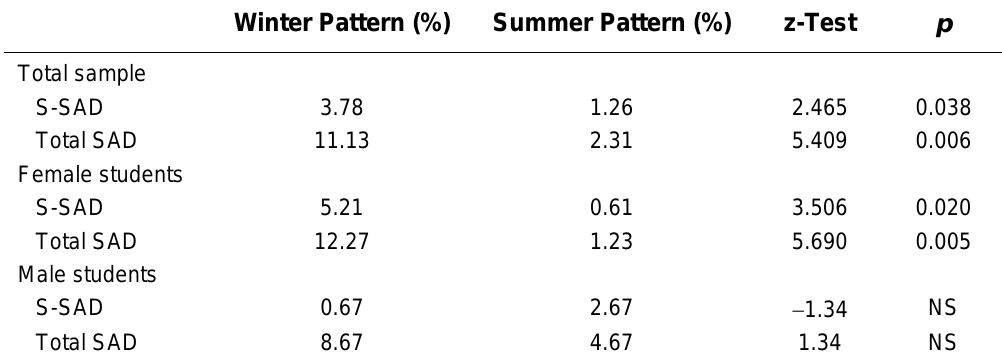
Prevalence of Winter- vs. Summer-Type S-SAD and Total SAD by